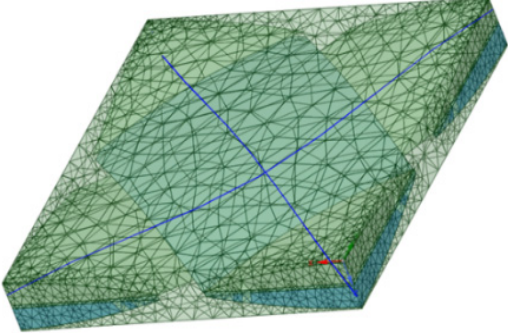
Figure 13. RVE e-glass material model